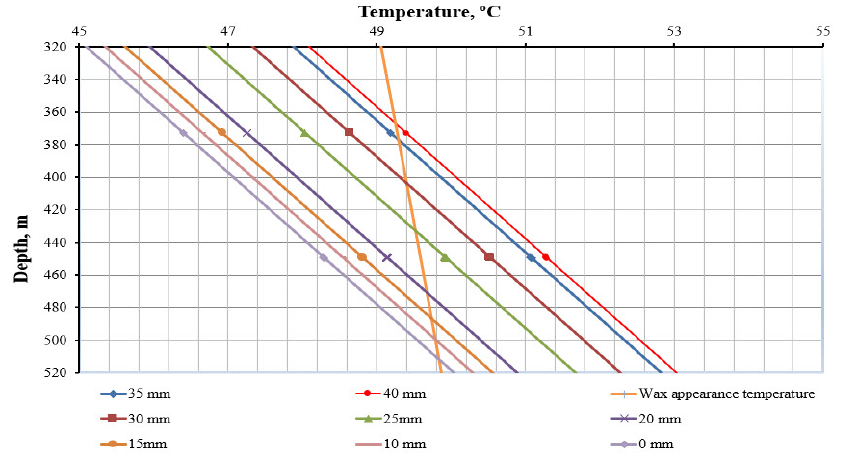
Figure 4. Selection of the optimal thickness of the heat-insulating polyurethane layers.